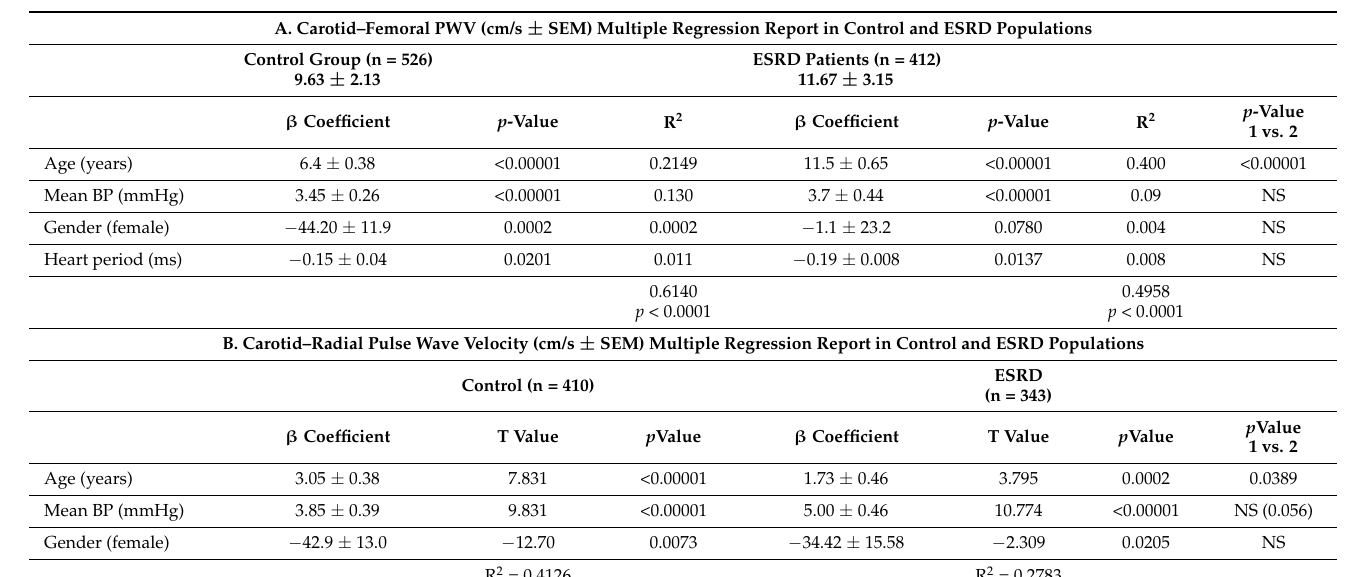
Table 1. Multiple regression reports concerning factors associated with pulse wave velocity in central elastic and peripheral muscular arterial